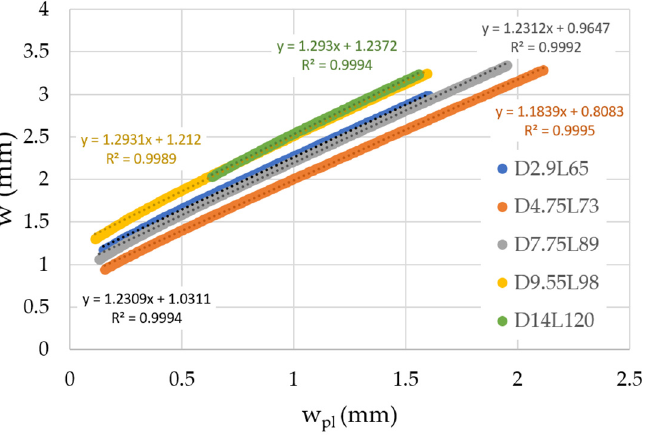
Figure 8. Dependences of total deflection on plastic deflection evaluated from three-point bending tests.